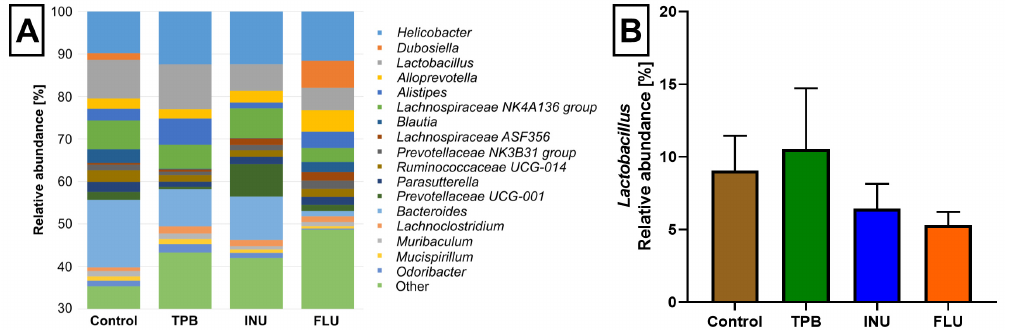
Figure 8. Relative abundance of bacterial phyla identified in tested groups of samples.